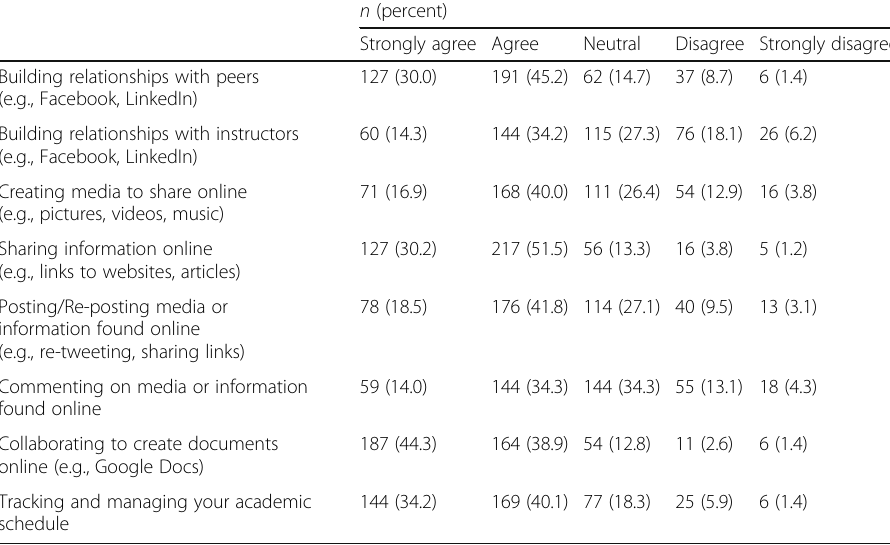
n (percent) Strongly agree Agree Neutral Disagree Strongly disagree 127 (30.0) 191 (45.2) 62 (14.7) 37 (8.7) 6 (1.4)